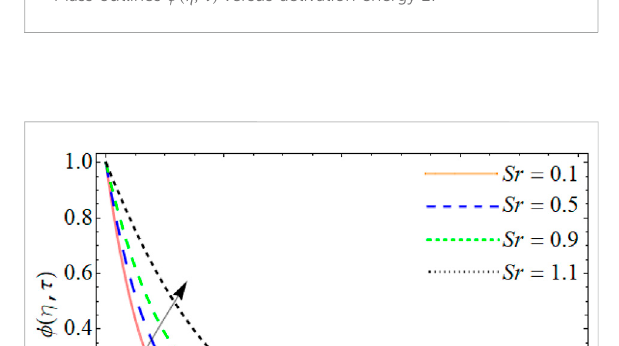
FIGURE 16 Mass outlines ϕ ( η , τ ) versus activation energy E .